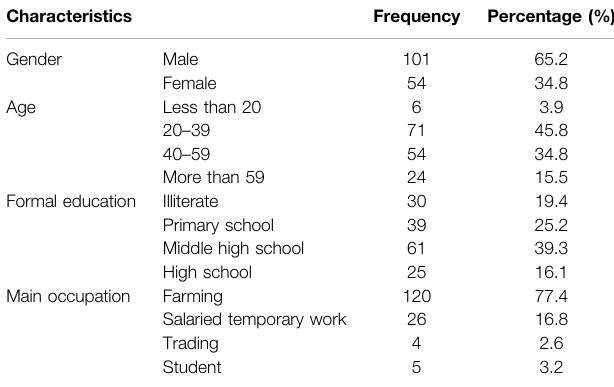
TABLE 1 | Demographic characteristic of